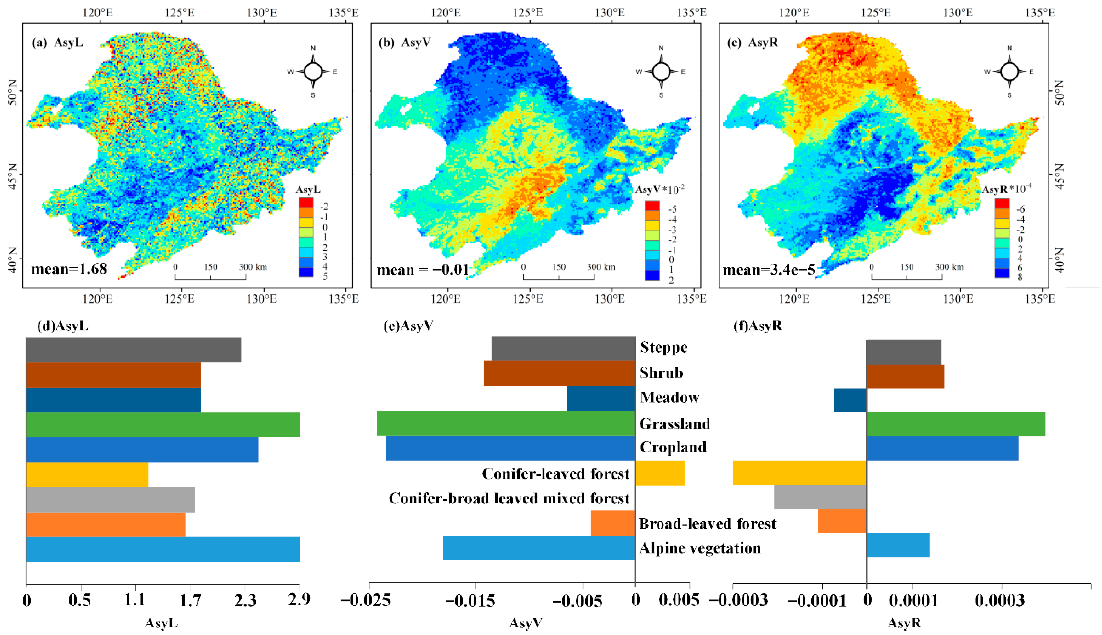
Figure 4. Spatial distribution of multi-year averaged asymmetric metrics ( a – c ) and statistical distribution ( d – f ).